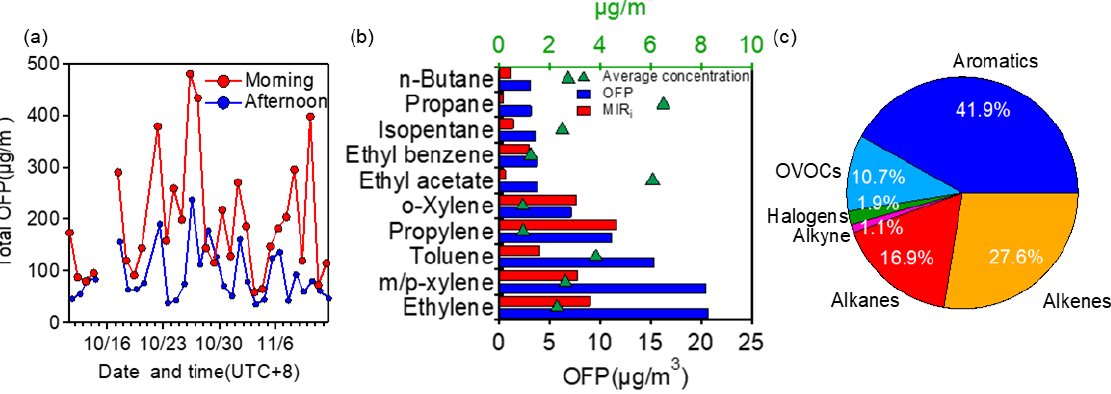
Figure 5. ( a ) TVOC OFP values for samples in the morning and afternoon, ( b ) top 10 species of OFP (as well as their MIR values and average concentrations), and ( c ) relative contributions of different VOCs to the OFP.